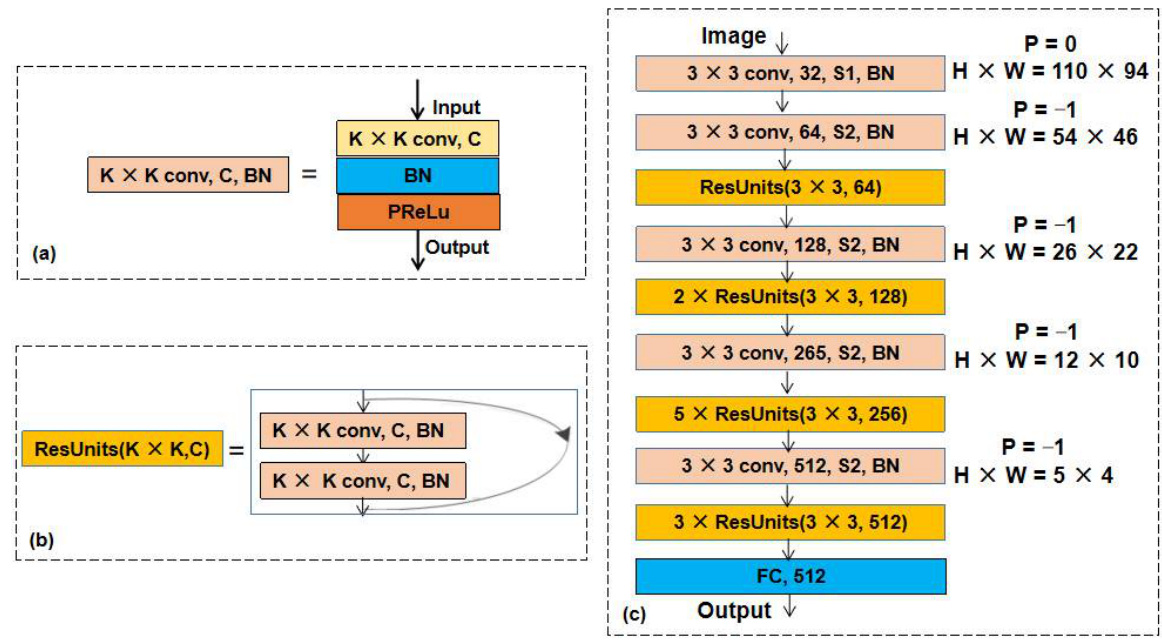
Figure 6. MDCNN for extraction of face features. ( a ) Convolutional layer with Batch Normalization. ( b ) Structure of ResUnits. ( c ) Over all architecture of MDCNN. Where “K” means kernel size, “C” means channels, “H” means the height of image, “W” means the width of image, and “P” means padding. “3 × 3 conv, 64” denotes the convolution layers with 64 filters of size 3 × 3, S2 denotes stride 2, and “FC” is fully connected layer.